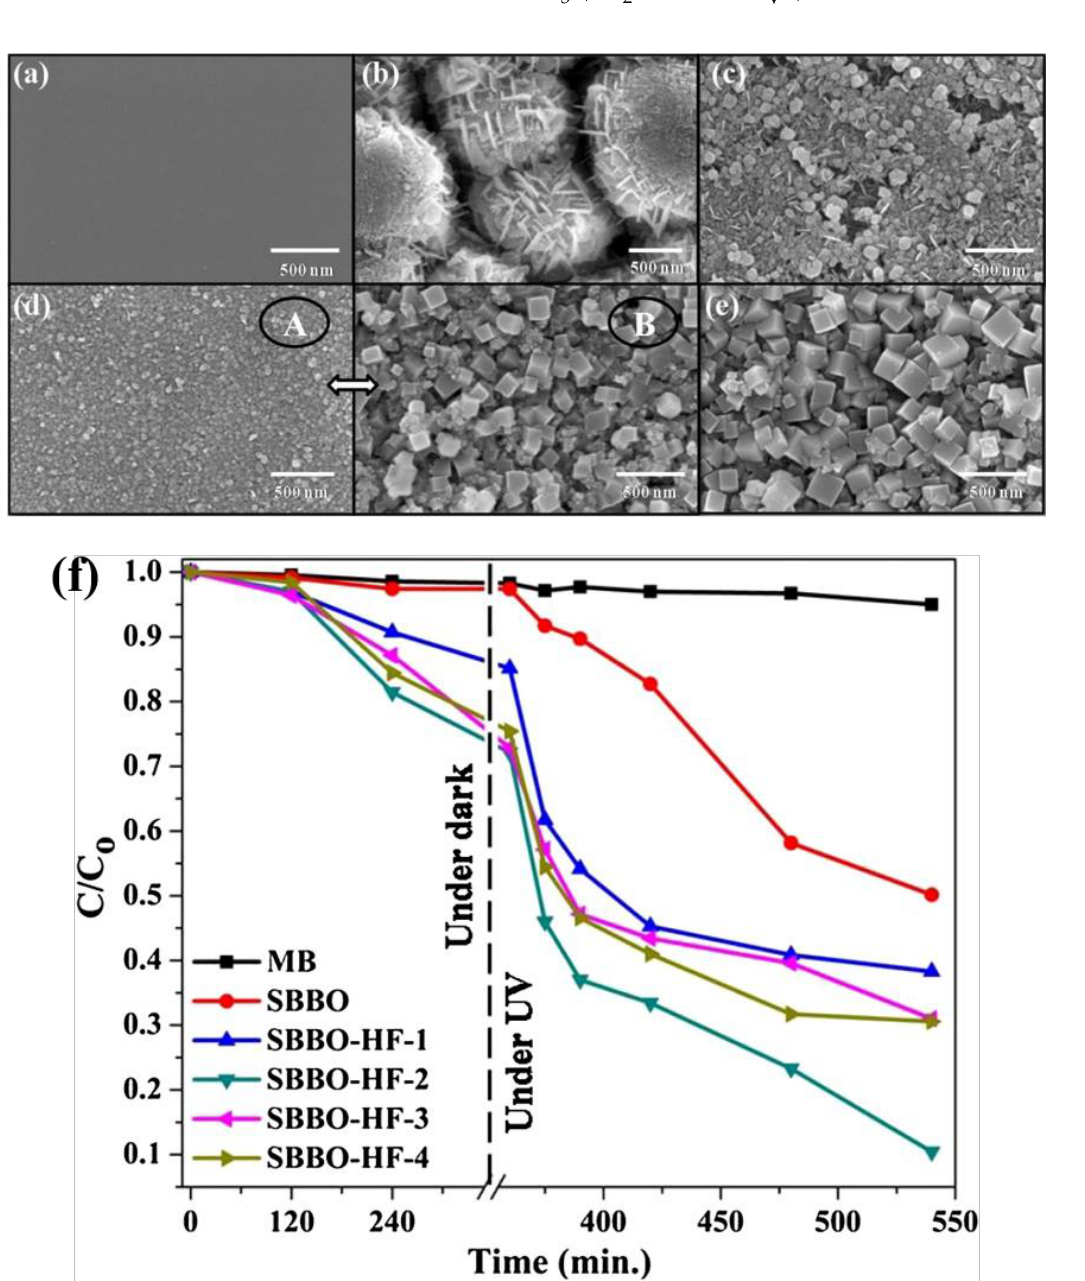
Figure 12. Focused SEM images of ( a ) as-quenched SBBO GC and etched SBBO GCs from HF solutions of different concentrations named as ( b ) SBBO-HF-1, ( c ) SBBO-HF-2, ( d ) SBBO-HF-3 (showing two different highlighted regions A and B) and ( e ) SBBO-HF-4, respectively. ( f ) The Ct/Co curves for the adsorption – desorption of MB solution under dark and photocatalysis degradation under 420 nm irradiation for as-quenched and HF etched SBBO GCs with different concentration solutions. Reprinted with permission from Ref.